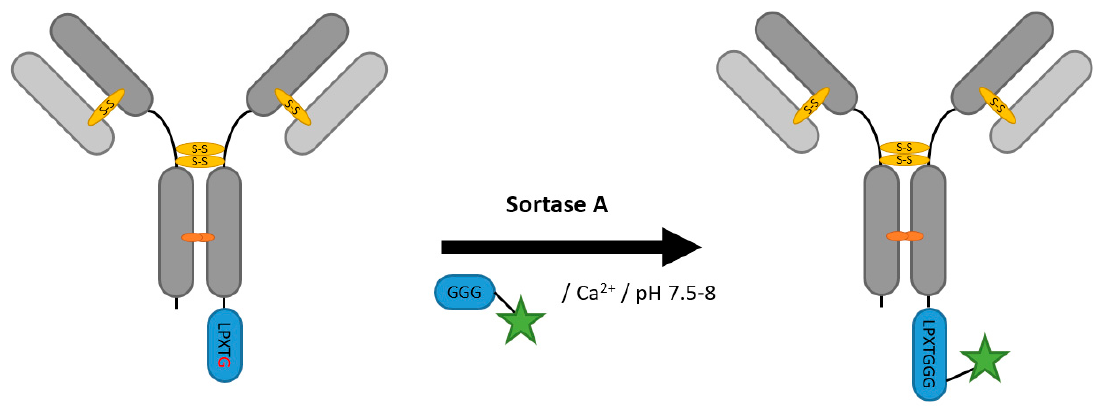
Figure 3. Scheme of an antibody modification with sortase.